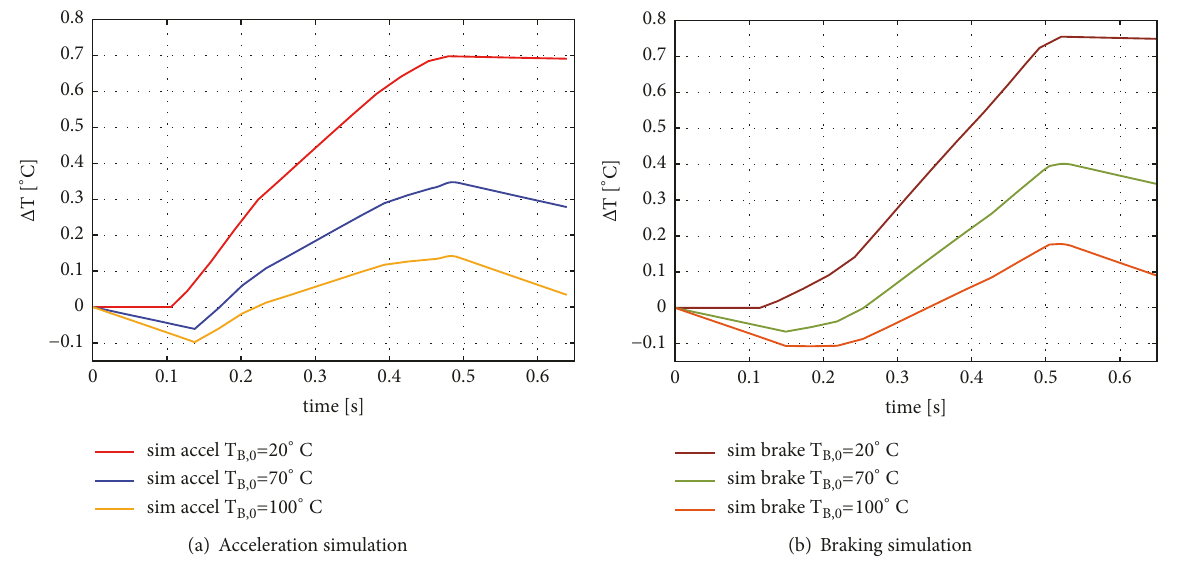
Figure 12: Temperature amplitude in the acceleration and braking simulation.